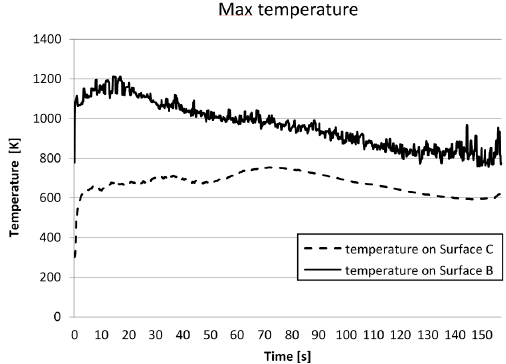
Figure 4. The trend of the maximum temperature reached in the surface B and C during the 157 s of the door opening.